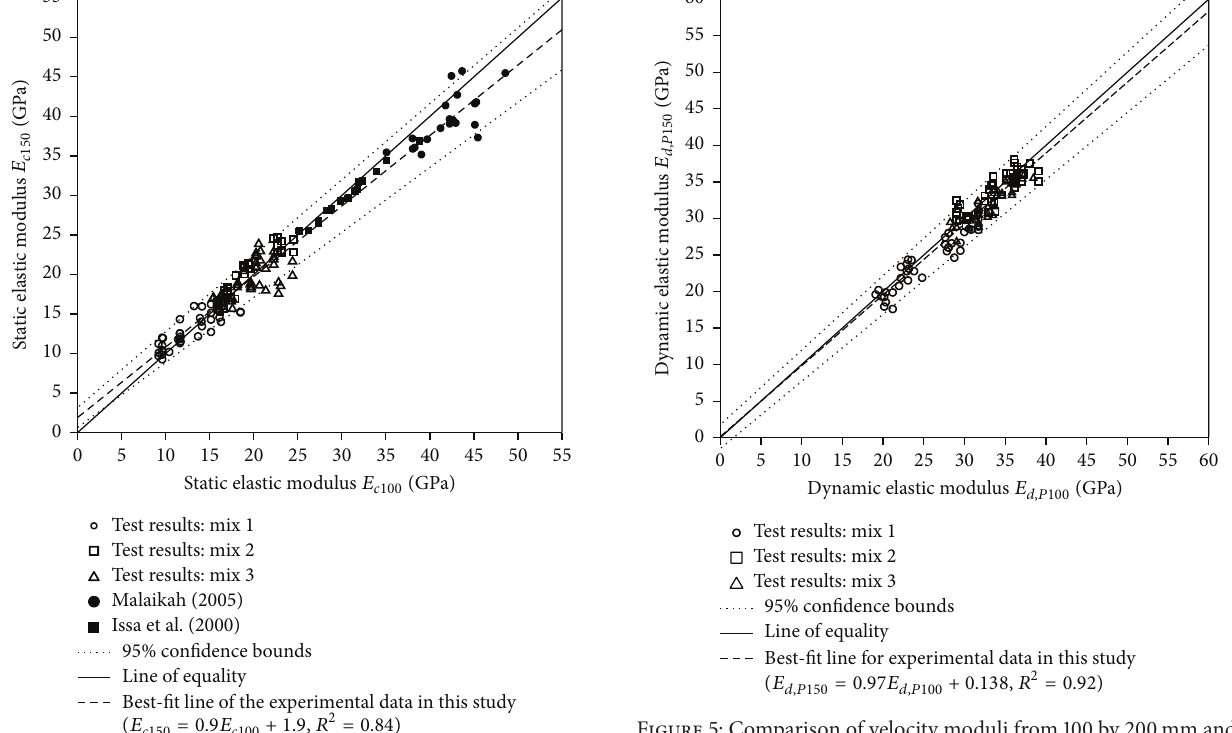
Figure 5: Comparison of velocity moduli from 100 by 200 mm and 150 by 300 mm